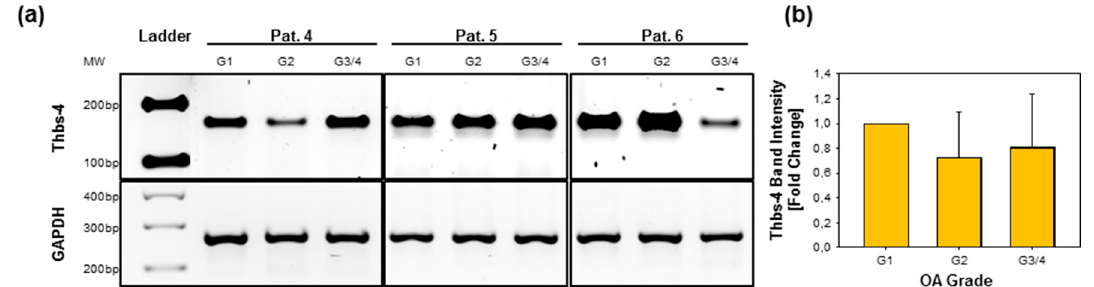
Figure 4. Thrombospondin-4 gene expression in OA knee articular cartilage. ( a ) Thbs-4 gene expression was analyzed by RT-PCR, followed by agarose gel electrophoresis. The Thbs-4 amplicons were normalized to the housekeeper GAPDH. Representative gels of RNA isolated from three different donors are shown. ( b ) No difference in gene expression could be detected when comparing the band intensities for different OA severity grades normalized to G1 (=1). Values are presented as means ± SD and significance ( p < 0.05 *; p < 0.01 **; p < 0.001 ***) was analyzed by Friedman test with Tukey post hoc analysis. OA severity grades: grade 1 (G1), grade 2 (G2), and grade 3/4 (G3/4). Pat. = patient; OA = osteoarthritis.